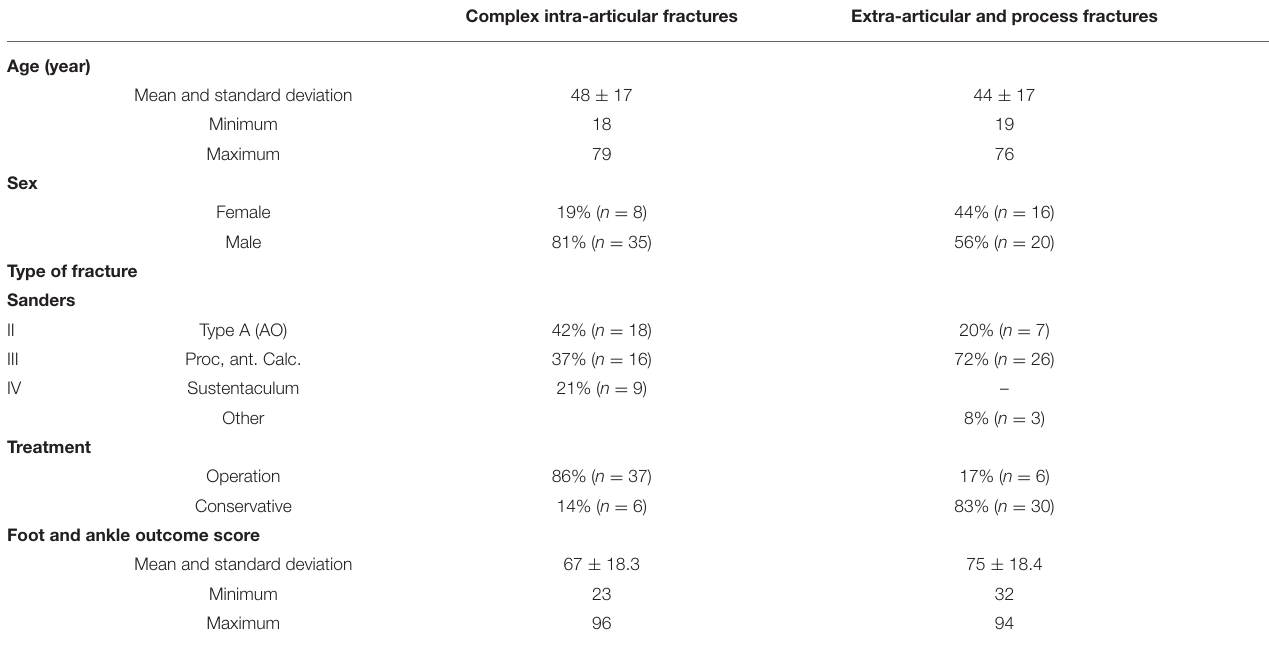
TABLE 1 | Overview of general data and functional outcome of patients with complex intra-articular and extra-articular/process fractures of the calcaneus. Complex intra-articular fractures Extra-articular and process